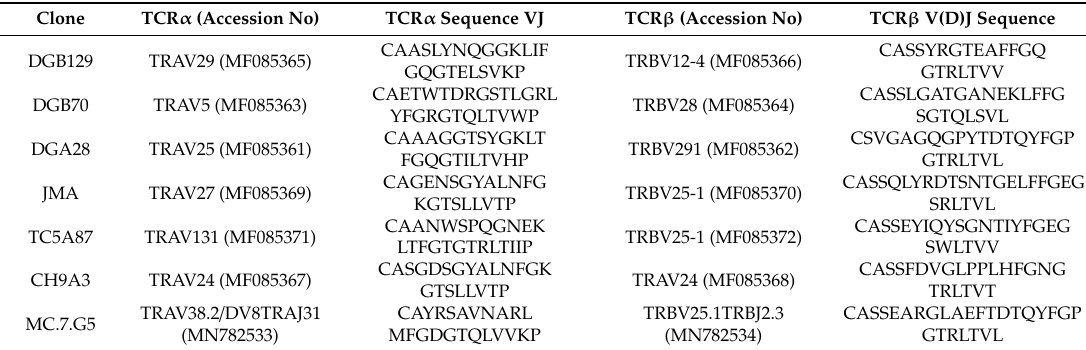
Table 2. The CDR3 Sequences of TCRs in MR1T Cell